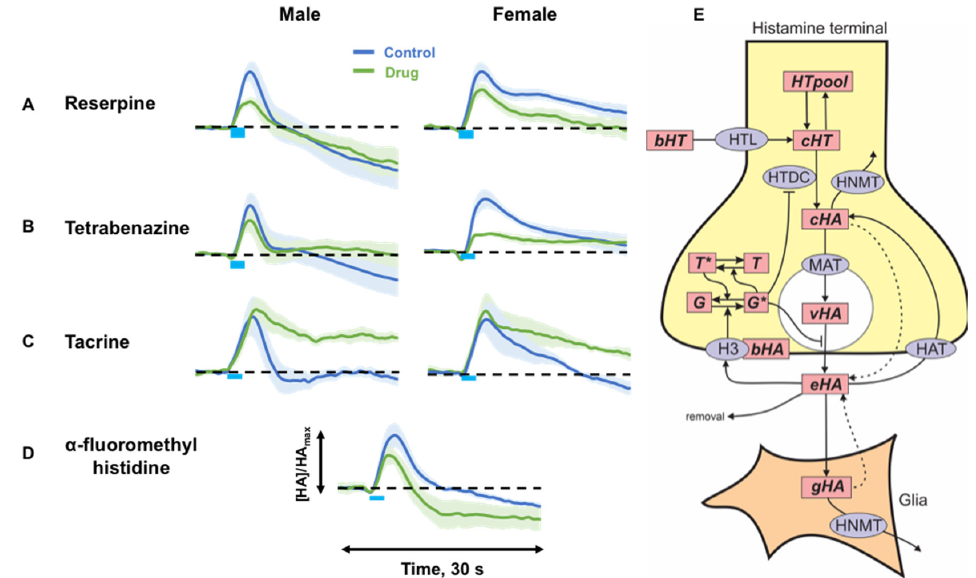
Figure 2. ( A–D ) Averaged concentration vs. time traces for control (blue) and post-drug (green) evoked histamine. The drug and mouse’s sex are listed. For α -fluoromethylhistidine male and female traces were averaged ( E ) Schematic representation of basic histamine metabolism, abbreviations are: bHT, blood histidine; cHT, cytosolic histidine; HTpool, the histidine pool; cHA, cytosolic